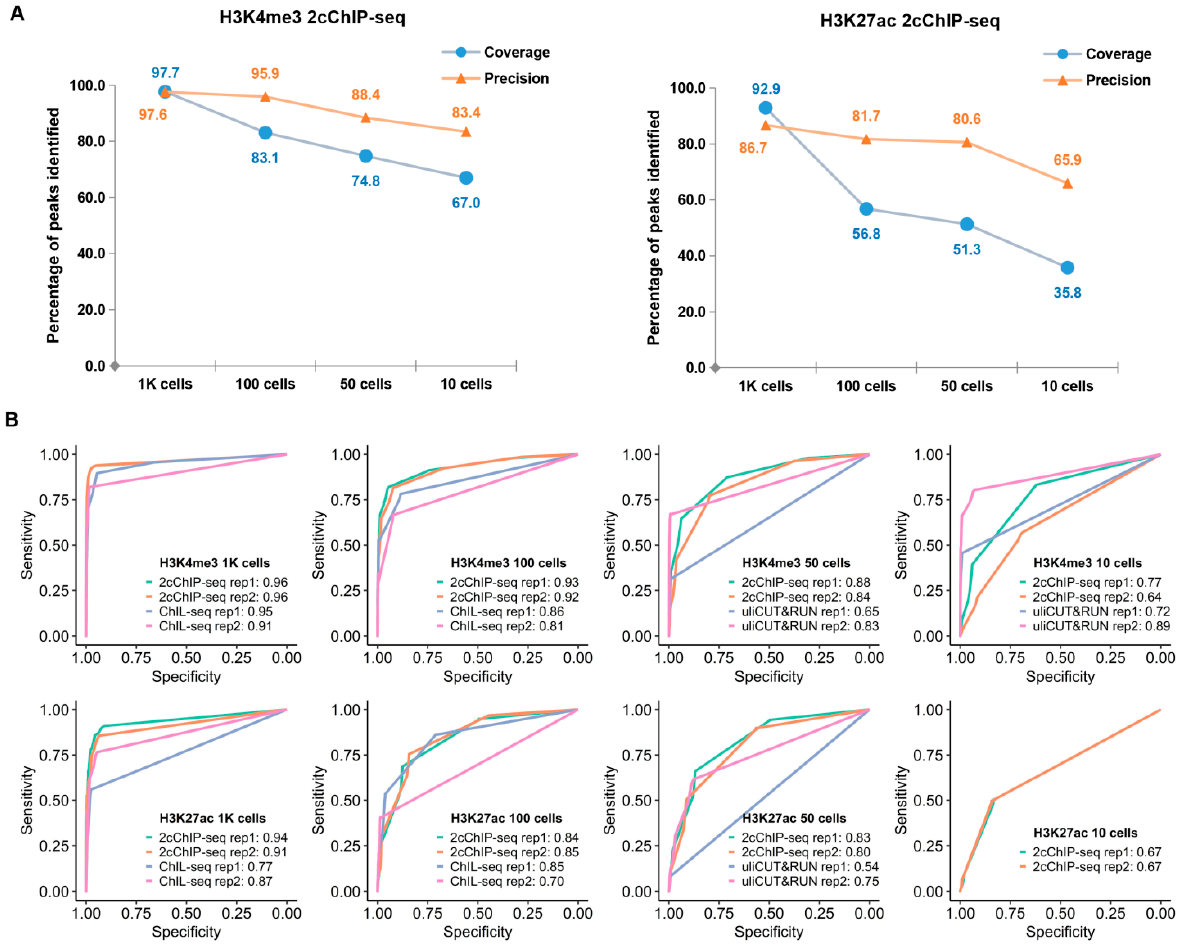
Figure 3. Performance comparison between 2cChIP-seq and other epigenomic profiling methods. ( A ) Line charts showing the coverage and precision of 2cChIP-seq peaks in the promoter region compared with those of ENCODE ChIP-seq data (H3K4me3, GSM2534289; H3K27ac, GSM733656). ( B ) ROC curves for the comparison of H3K4me3 and H3K27ac, respectively. ROC curves were constructed by comparing the data generated by distinct methods for low sample input with published data. The raw data of ChIL-seq and uliCUT&RUN are from GSE115047 and GSE111121, respectively. The values shown are for the area under the ROC curve (AUC).